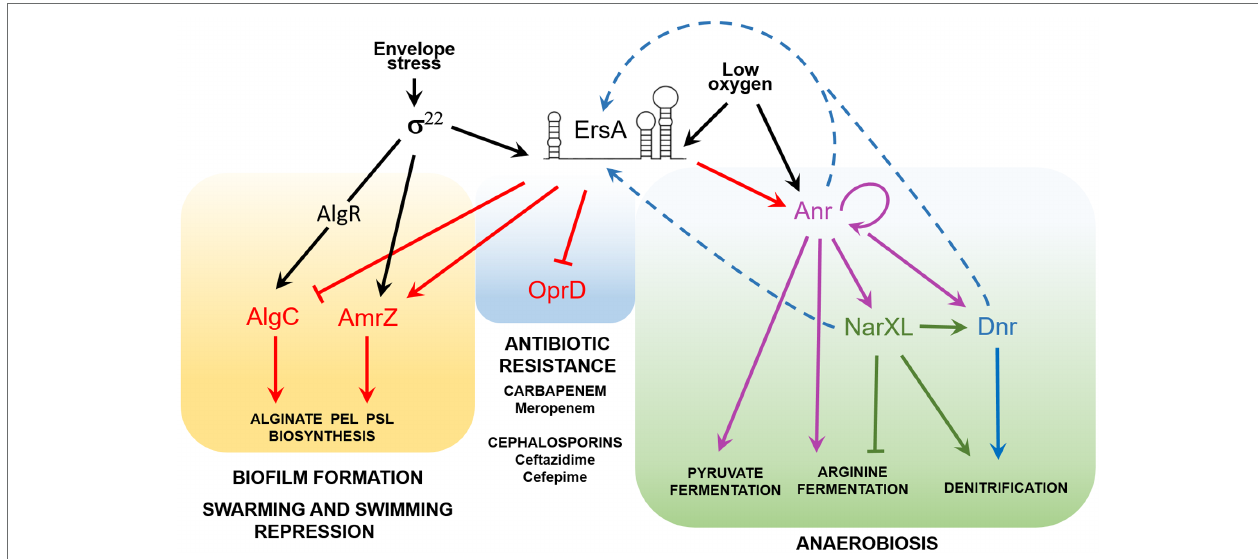
FIGURE 4 | The ErsA regulatory network in P. aeruginosa . Acting as a post-transcriptional modulator, ErsA influences several virulence traits of P. aeruginosa , related to biofilm formation, repression of swarming and twitching motility, antibiotic resistance, and metabolic adaptation to low-oxygen environments typical of CF lung infection. ErsA modulates alginate and exopolysaccharides (Pel and Psl) production by activating the AmrZ regulon and through the fine-tuning of AlgC levels. The regulatory circuit is mediated by the envelope stress-responsive sigma factor σ 22 , which in P. aeruginosa triggers ErsA levels and is responsible for the transcription of amrZ mRNA and the activation of algC through the regulator AlgR. ErsA negatively regulates the expression of the major porin oprD, responsible for the uptake of carbapenem antibiotics, thus leading to increased resistance to meropenem. By unknown mechanisms, ErsA contributes also to ceftazidime and cefepime resistance, two antibiotics that belong to the class of cephalosporins. ErsA modulates the expression of genes for anaerobic growth and survival. Low- oxygen levels trigger the transcription of ErsA, which positively modulates the expression of the transcription factor Anr, the master regulator of anaerobiosis. Activation of Anr by dimerization is also promoted by low-oxygen tension. Other genes involved in anaerobic adaptation are also regulated by ErsA by an unknown mechanism. The signal that activates ErsA expression under an anaerobic or low-oxygen environment is still unknown. We speculate that ErsA expression can be controlled by transcription factors like Anr, Dnr, or NarXL (blue dotted arrows). A putative NarL box (TACCGCT) is present from 179 to 173 nt upstream of the ersA transcription start